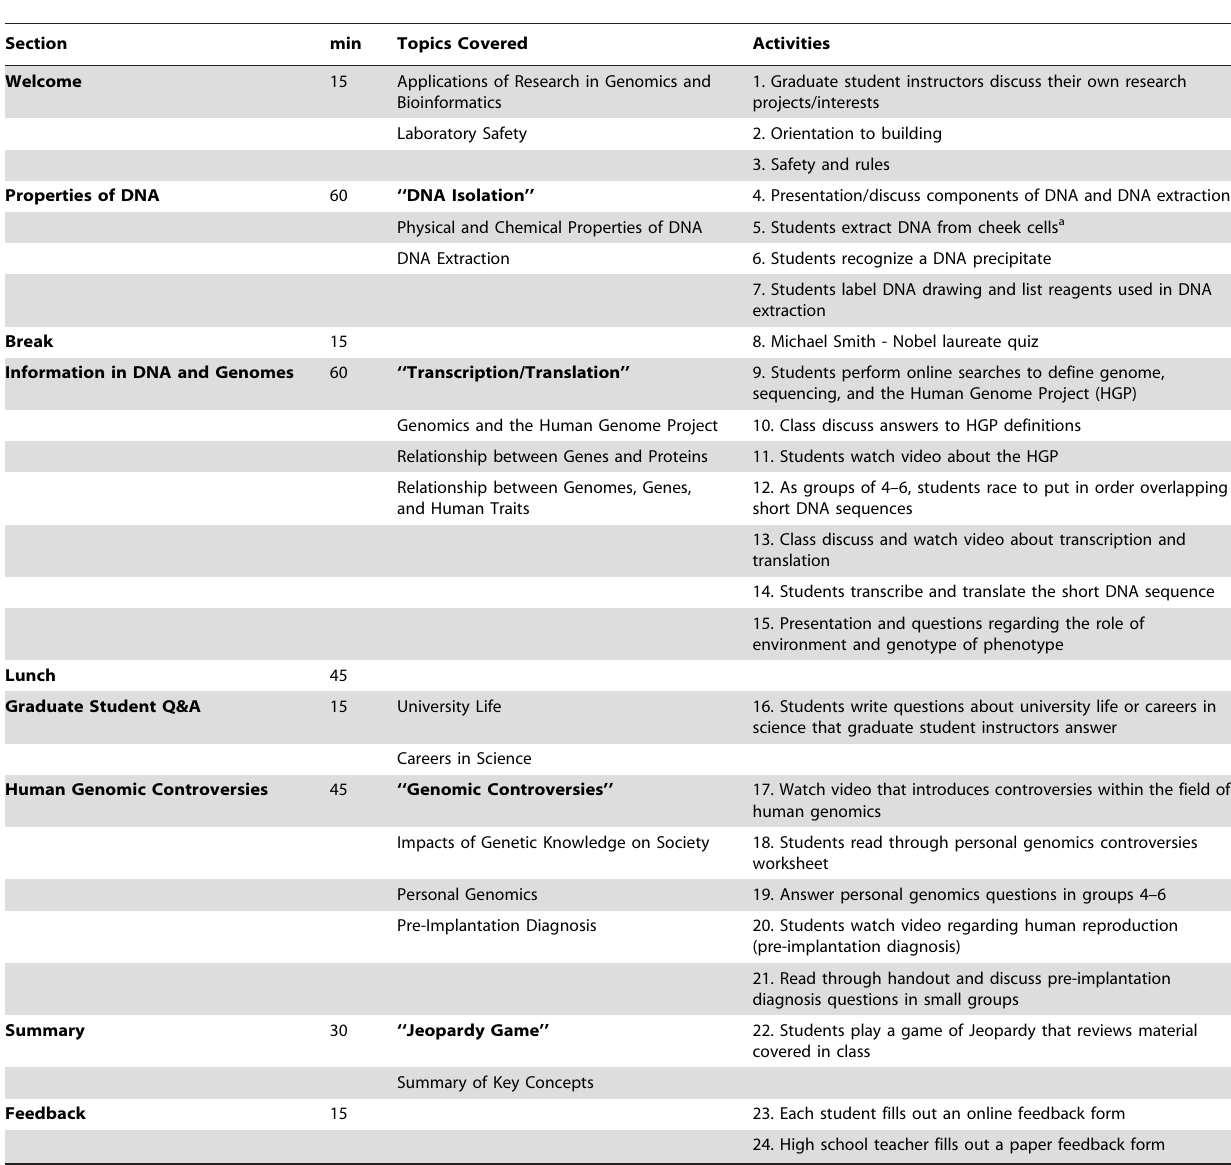
Table 1. Topics and activities covered by the Genomics Field Trip Program.